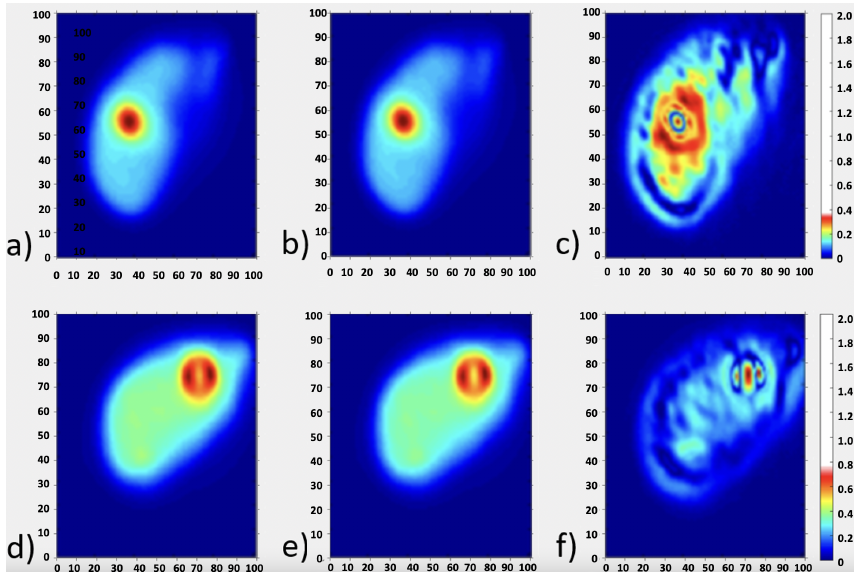
Figure 4. The dose distributions for AbdoMan phantom reconstructed with xSPECT software using dose kernel method ( a , d ) and local energy deposition method ( b , e ) for two different slice’s location corresponding to the three investigated spheres. ( c , f ) γ -maps related to the slices